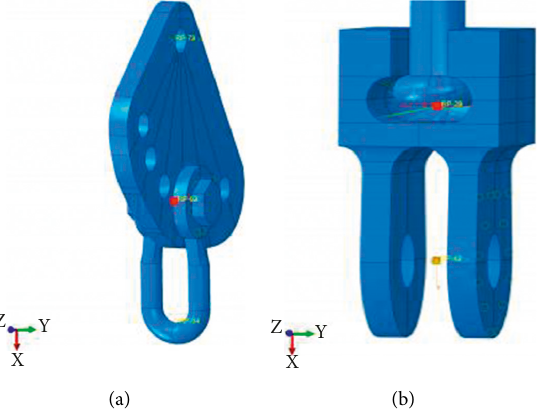
Figure 20: Connection section type: (a) “Hinge” (b) “Join” and